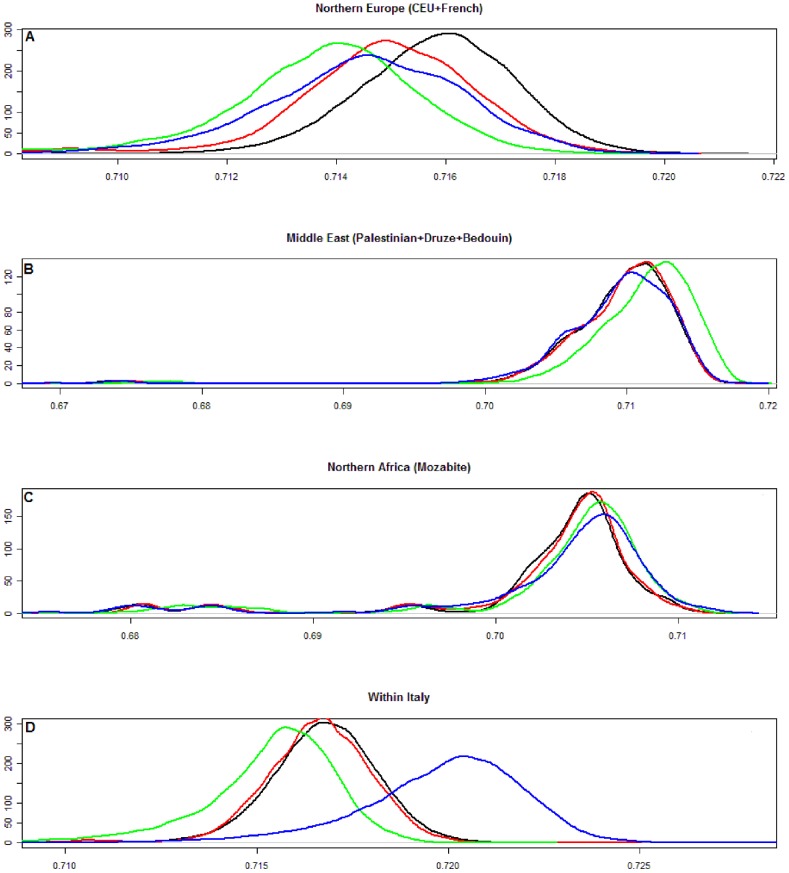
Clustering of the European, Northern African and Middle Eastern individuals by the Structure software.Model-based ancestry analysis based on a subset of HGDP-CEPH and HapMap CEU data using the merged data of 126K autosomal SNPs. Ancestry for each individual was inferred using ADMIXTURE [50] at K = 4. Abbreviations as in Figure 1.